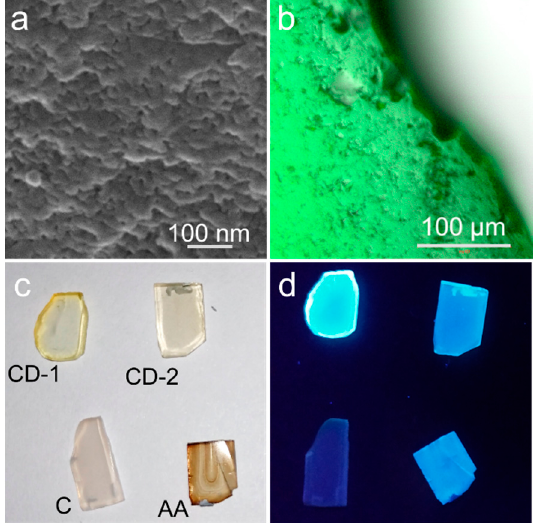
Figure 3. ( a ) SEM image taken from the edge of CD-1@NSG composite. ( b ) Overlay of the microscopic images of the CD-1@NSG composite in transmission and luminescent channels in artificial (green) color. Photographs of the CD-1@NSG, CD-2@NSG, C@NSG and AA@NSG samples under ( c ) visible and ( d ) UV light.